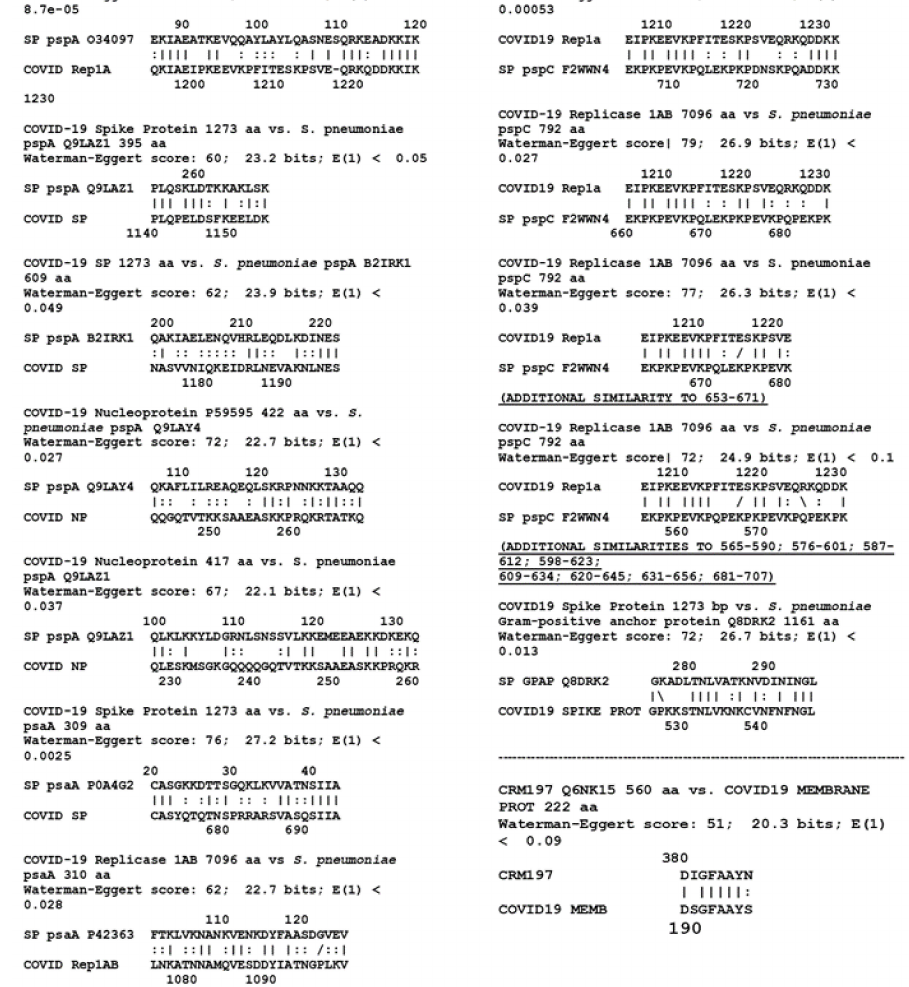
Figure 1. Similarities between the four known or probable pneumococcal vaccine protein contaminants PsaA, PspA, PspC, Gram-positive anchor protein and SARS-CoV-2 proteins, as well as CRM197, the modified diphtheria toxin to which pneumococcal conjugate vaccines are attached. Multiple variants for each protein were examined and the results provided here are representative of results at E =